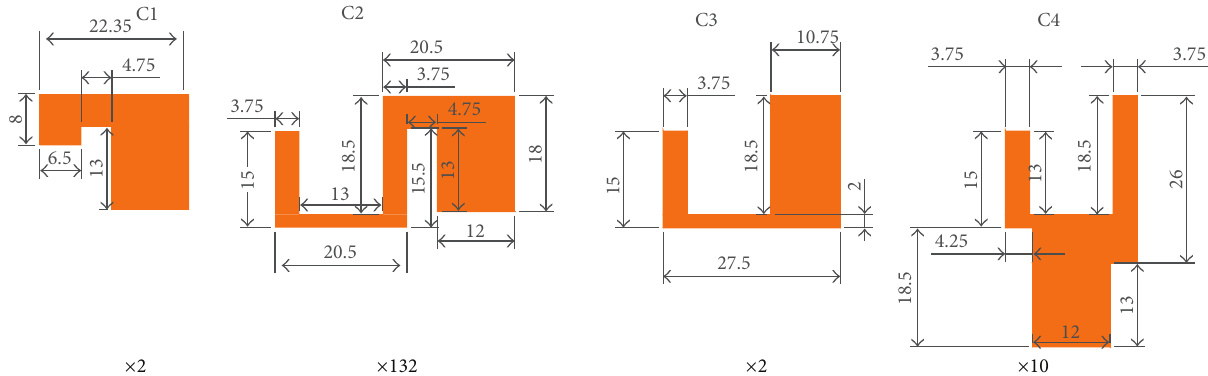
Figure 15: The four shapes of the V3.0: C1 recurs twice, C2 recurs 132 times, C3 recurs twice, and C4 recurs 10 times in the 144-cell design. Dimensions are in